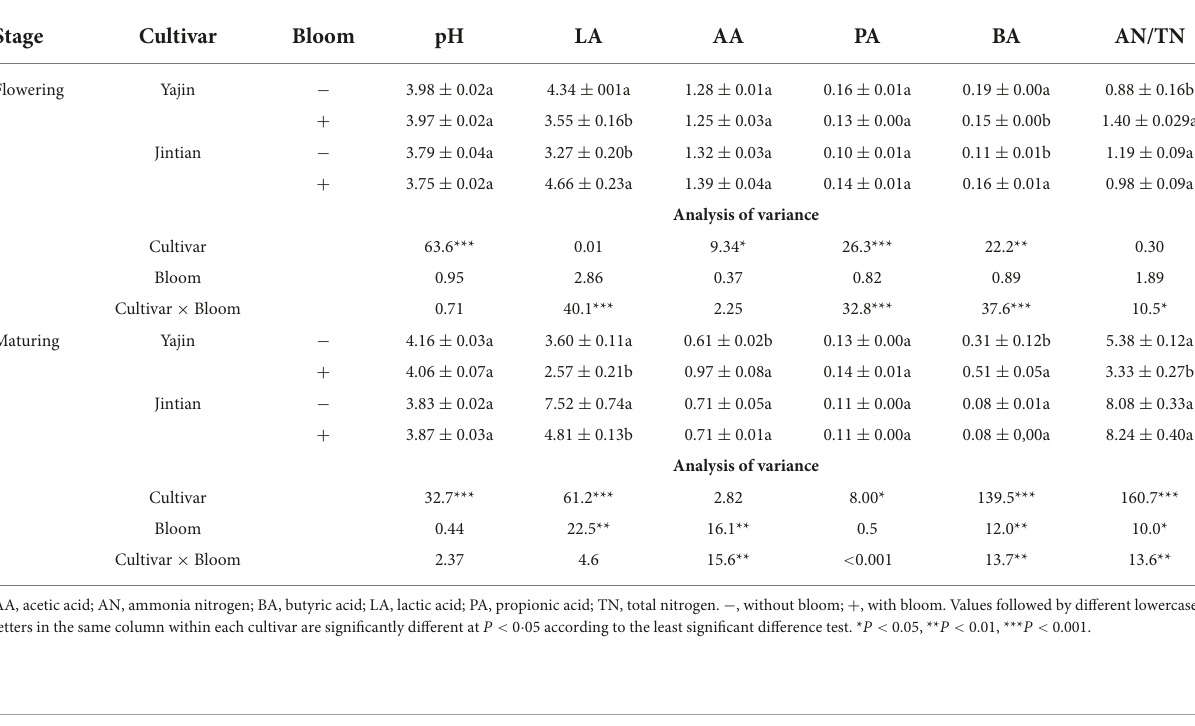
TABLE 4 The pH and fermentation products (%) and ammonia- N /total N of sweet sorghum silage at flowering and maturing stages.